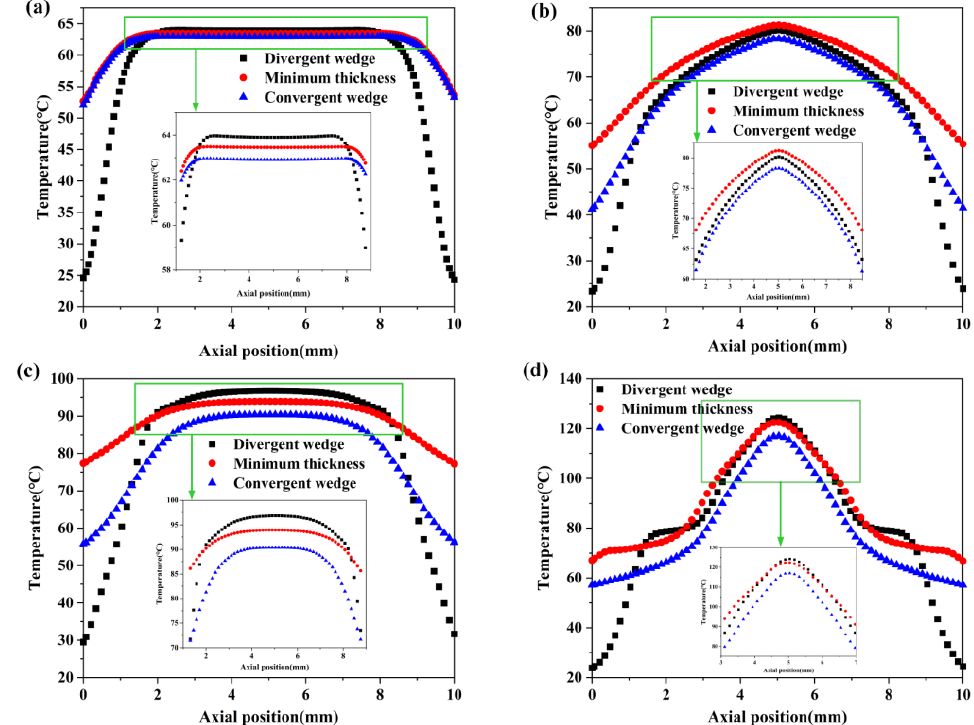
Figure 11. Temperature of magnetic fluid lubrication film. ( a ) ε = 0.2; ( b ) ε = 0.4; ( c ) ε = 0.6; ( d ) ε = 0.8.